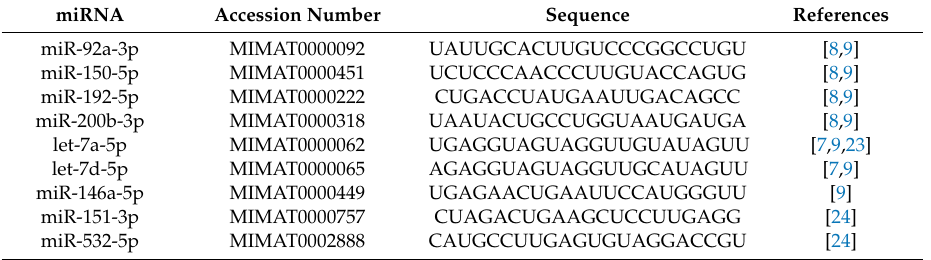
Table 2. Candidate miRNAs for grading liver fibrosis based on available literature. miRNA Accession Number